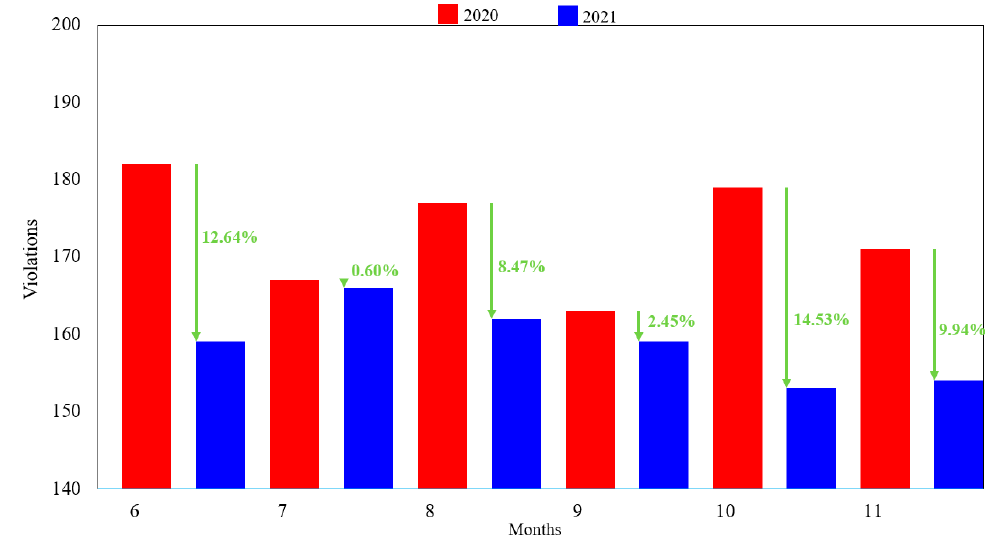
Figure 12. Comparative analysis of violation times of coal mine workers in 2020 and 2021.